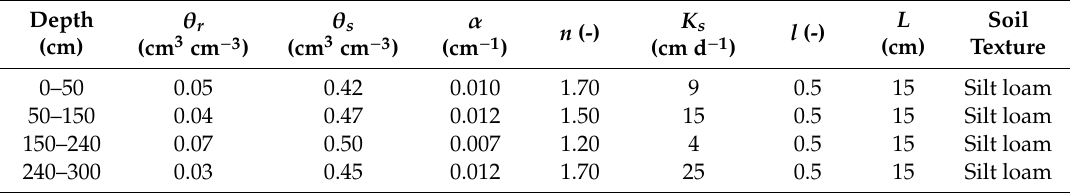
Table 1. Values of the van Genuchten–Mualem model parameters and dispersion length for di ff erent soil layers.